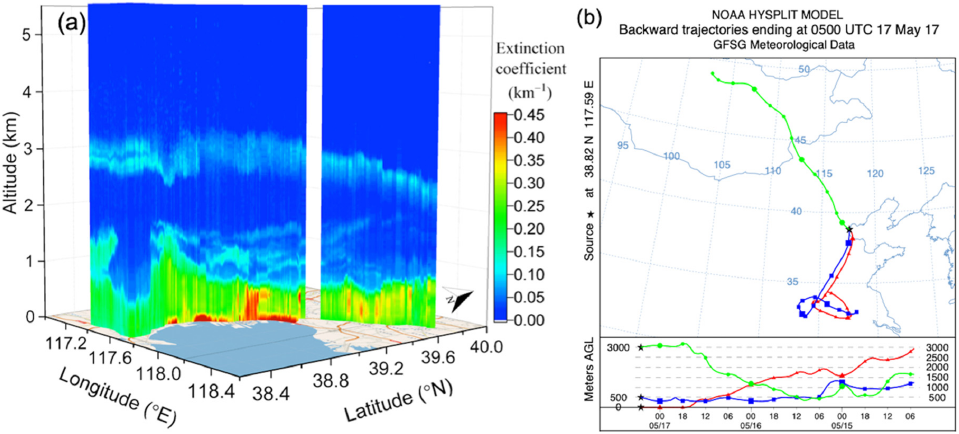
Figure 8. ( a ) 3D plot of the LIDAR-derived extinction profiles at 532 nm along the mobile transect from Tianjin to Tangshan and ( b ) 72 h backward trajectories arriving at a point along the mobile transect, near the Tianjin port (38.82 ° N, 117.59 ° E) on 17 May 2017, 05:00 UTC, at heights of 0 m (red), 500 m (blue) and 3000 m (green).